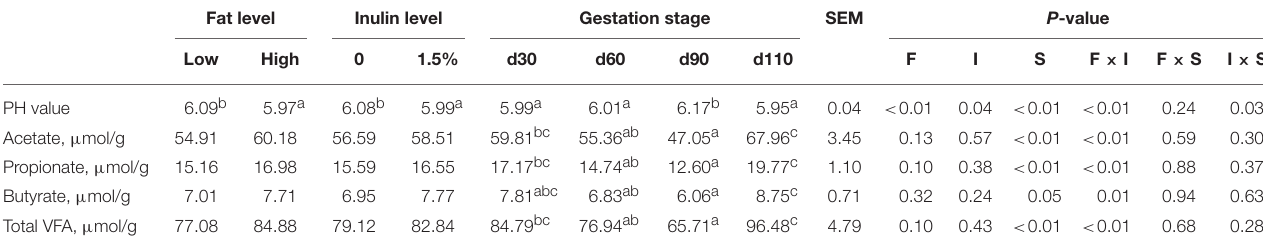
TABLE 2 | Effects of inulin addition to low- or high –fat diets on fecal VFA concentrations of gestating sows. Fat level Inulin